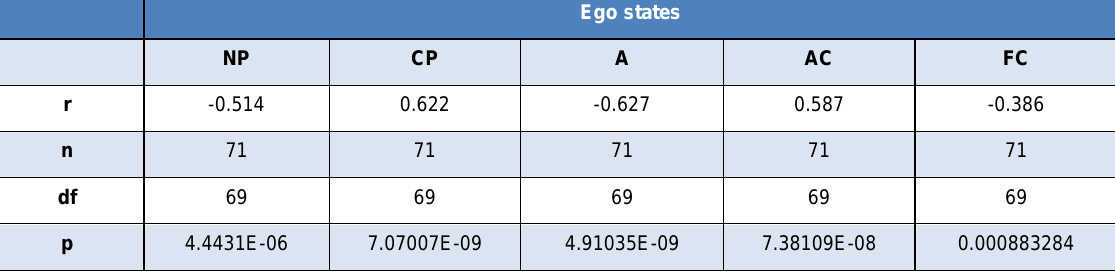
Table 6: Significance testing of r: Ego states and Neuroticism (Males)